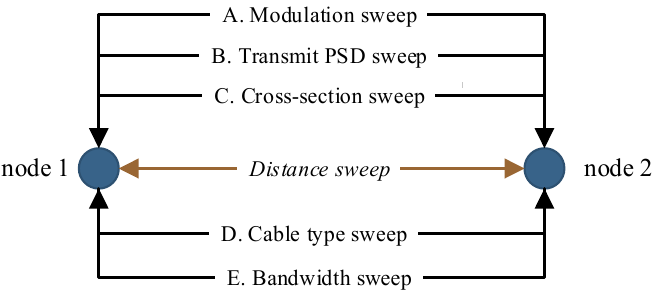
Figure 5. Simulation setup—swept parameters in point-to-point topology.